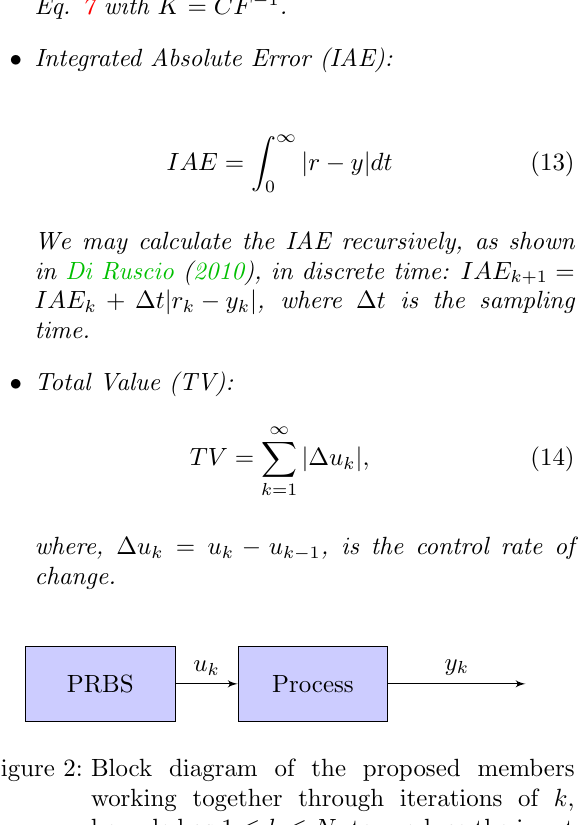
Figure 4: Block diagram of the proposed members working together through iterations of k , bounded as 1 ≤ k ≤ N , to control y k . The ‘LQR’ block is as Eq. 11 and the ‘State esti- mator’ block is as Eq.